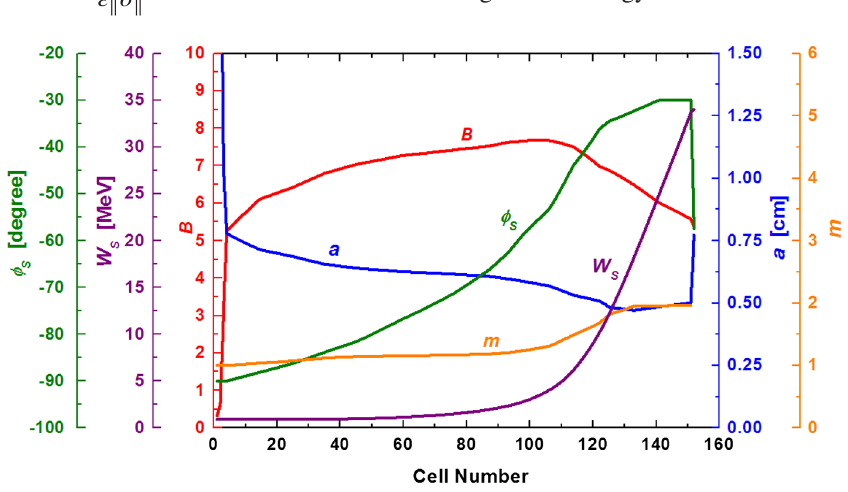
FIG. 4. The cell parameters of SSC_Linac